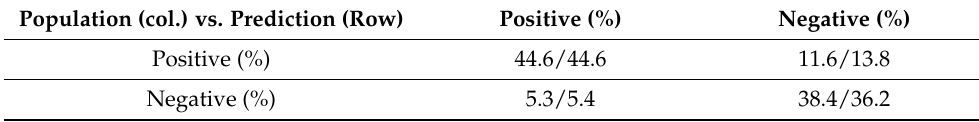
Table 4. Confusion matrix (local method/global